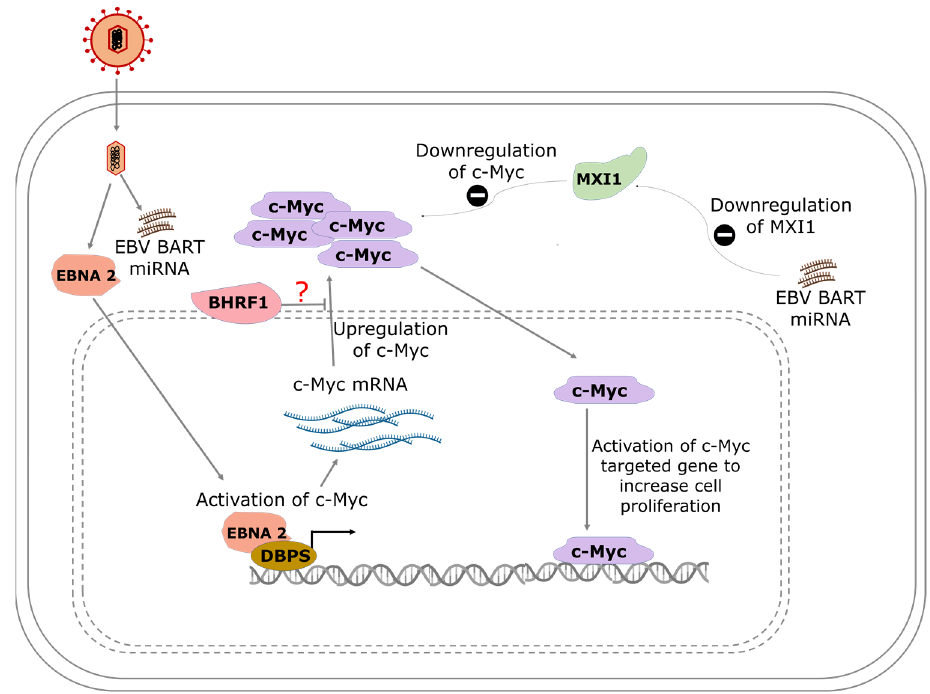
Figure 1. A model showing the pathways of EBV-mediated c-Myc activation in Burkitt’s lymphoma. EBNA-2 interacts with albumin D box-binding proteins (DBPs) to activate the transcription of c-Myc. Increased production of c-Myc results in the activation of the c-Myc-targeted gene to increase cell proliferation. EBV BART miRNA inhibits MAX interactor 1 (MXI1), which is known to repress the activity of c-Myc.